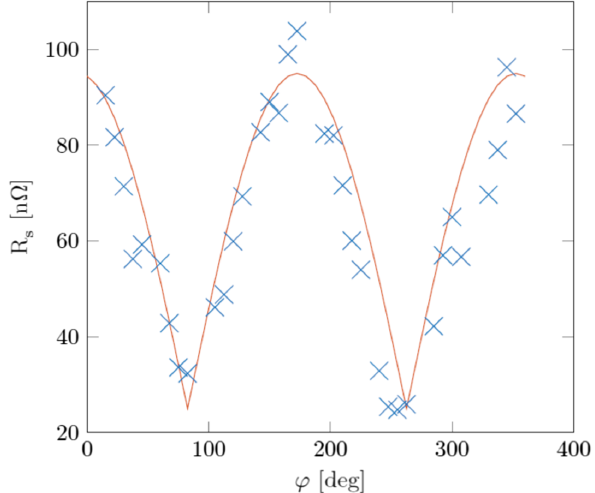
14. Calculated surface resistance vs azimuthal angle, with applied field in φ ¼ 0 °, α ¼ 0 °. Blue marks show averages of columns in Fig. 13. The red line follows y ¼ ð 70 × j cos ð φ þ 7 . 5 Þj þ 25 Þ n Ω